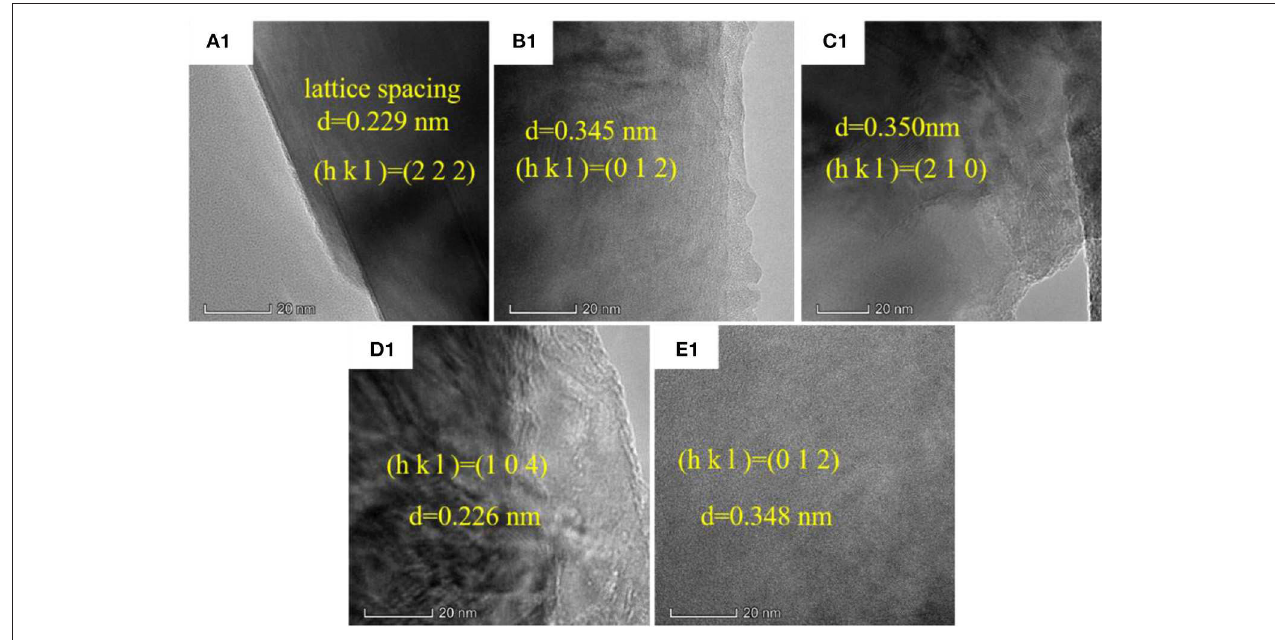
FIGURE 9 | High resolution TEM images of alumina ceramics: (A1) 1,300 ◦ C; (B1) 1,350 ◦ C; (C1) 1,400 ◦ C; (D1) 1,450 ◦ C; (E1) 1,500 ◦ C.